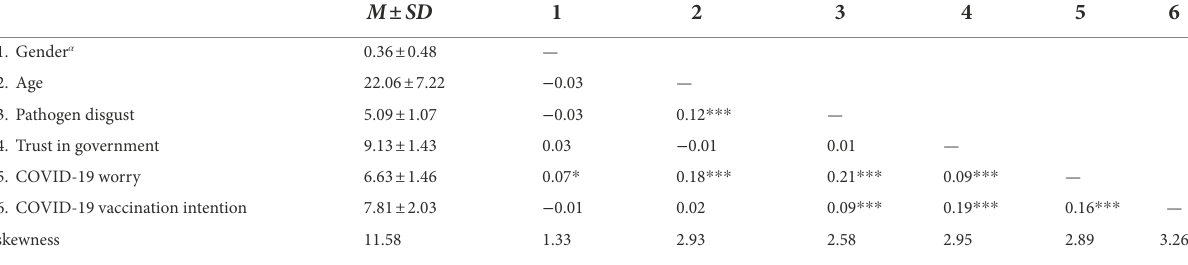
TABLE 2 Results of descriptive statistics and correlation of the